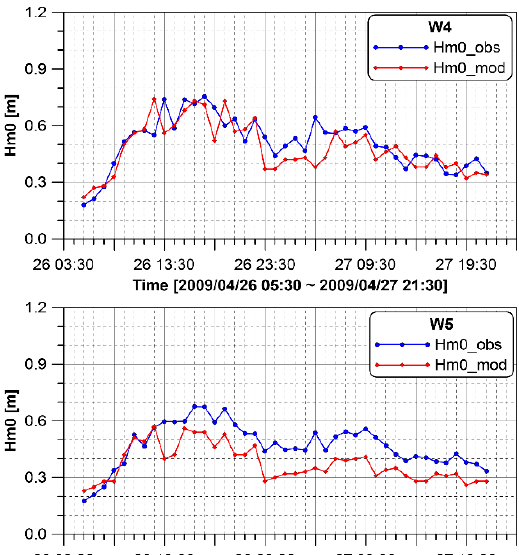
Figure 12. Comparison of wave conditions ( 𝐻 (cid:3040)(cid:2868) , 𝑇 (cid:2926) , and 𝐷 (cid:3043) ) between the observational (blue) and modeled (red) data in W1 during the period of the wave event selected for BC from 05:30 on the 26th to 21:30 on 27 April 2009 (39 h). It is noted that the modeled data matched well with the obser- vational data due to the proximity of W1 to the open boundary, as shown in the computational domain (Figure 4b).